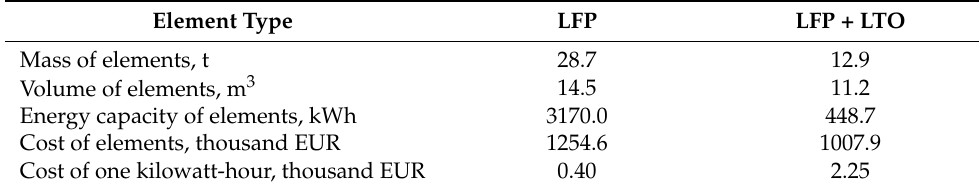
Table 6. Results of calculations of ES parameters with LFP- and LTO